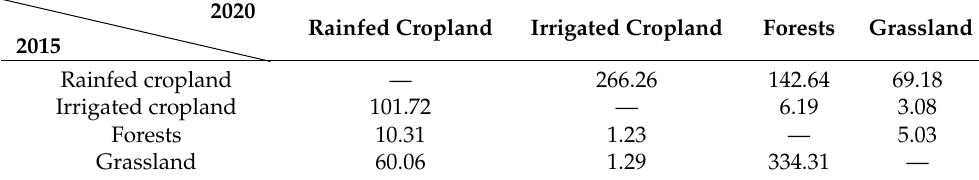
Table 2. FLC indices of hills under different distance thresholds.